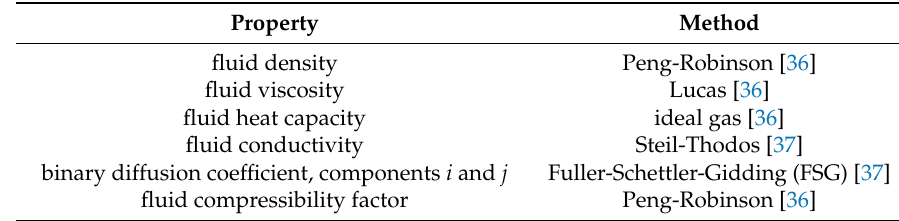
Table 5. Methods used to calculate physicochemical